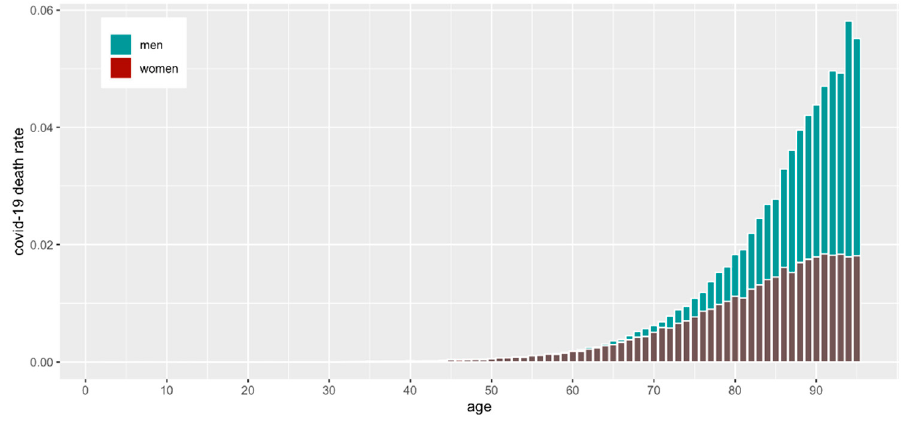
Figure 2. COVID-19 mortality as a percentage of the population by age and sex.